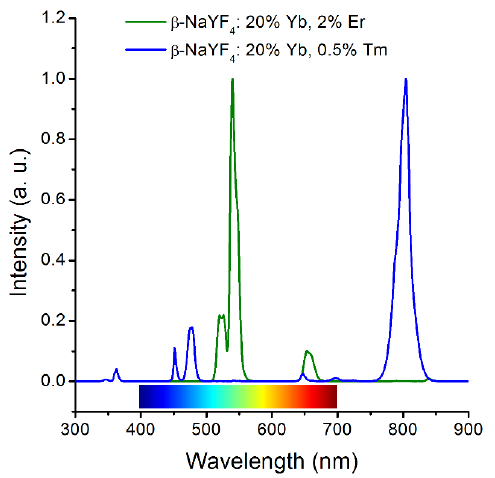
Figure 1. Typical upconversion spectra of β -NaYF 4 :20%Yb, 2%Er (dark green) and β -NaYF 4 :20%Yb, 0.5%Tm (blue).